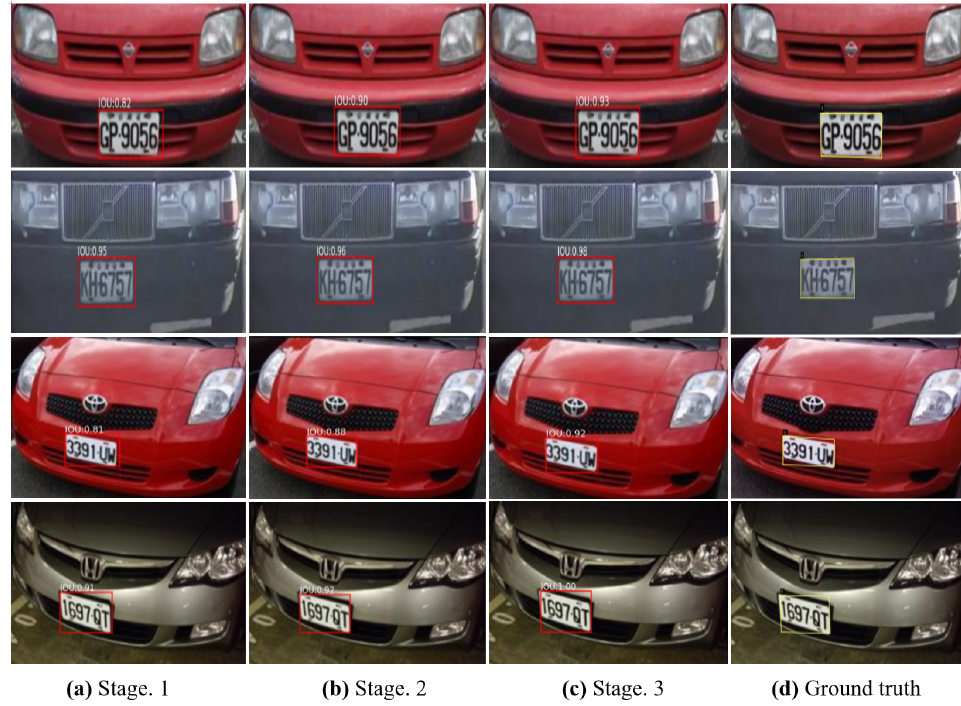
Figure 5. Results of different stages of the cascaded positioning